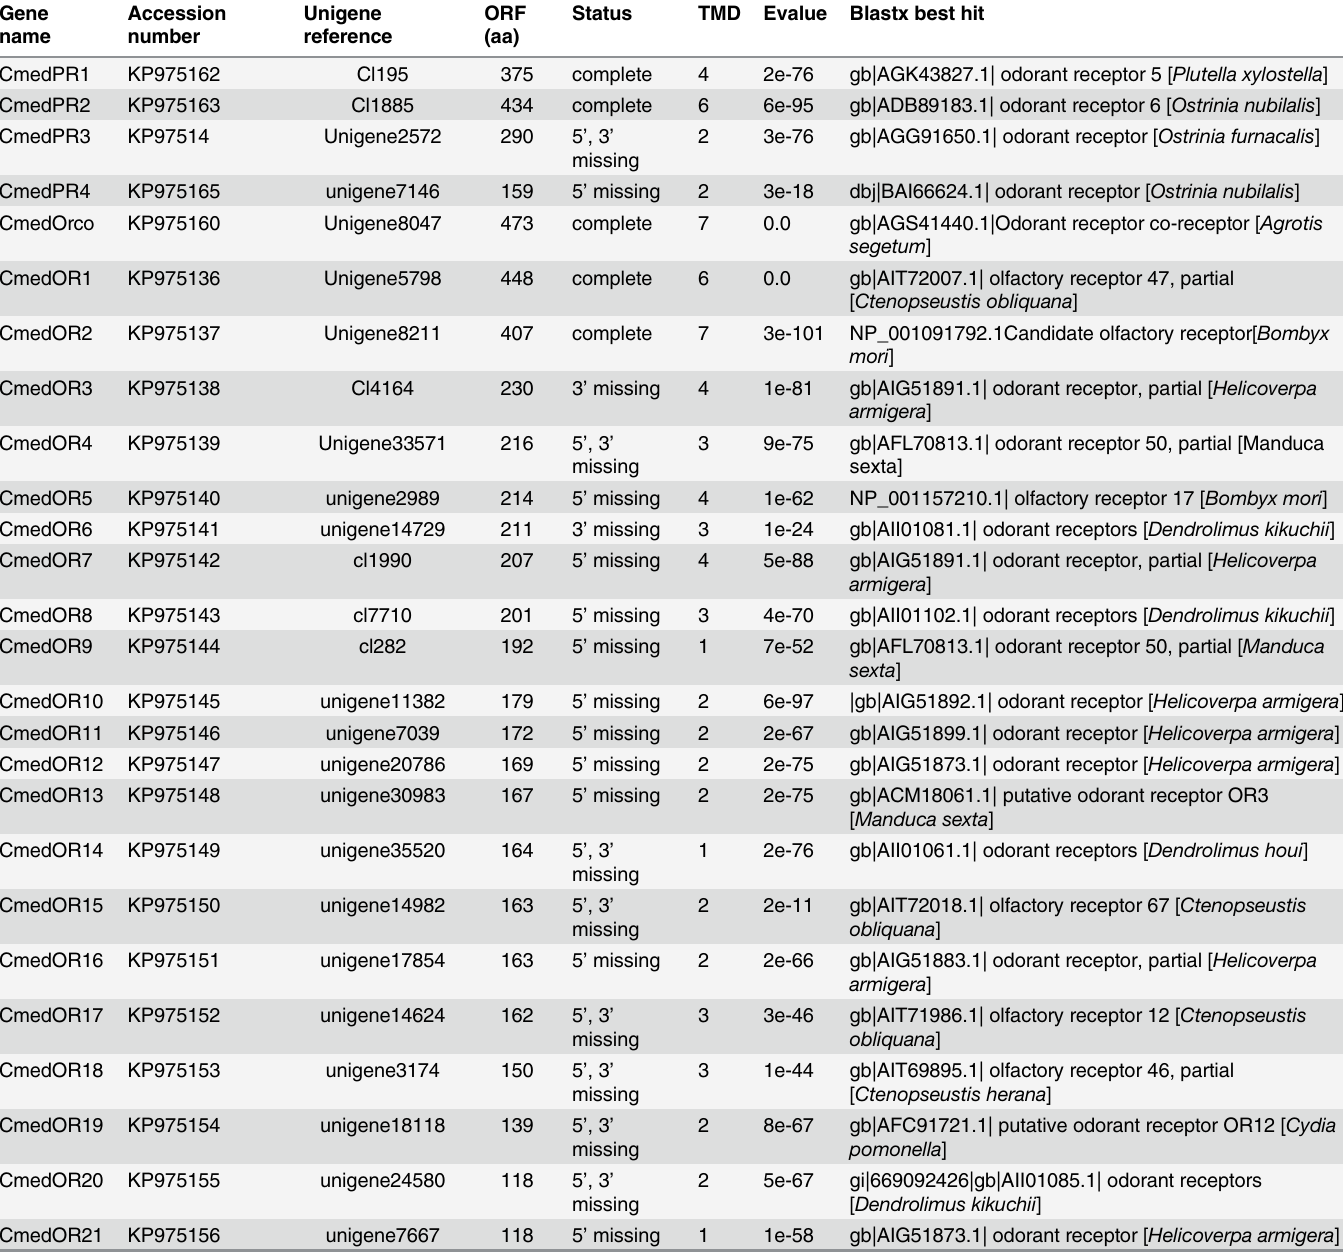
Table 2. Unigenes of candidates for olfactory